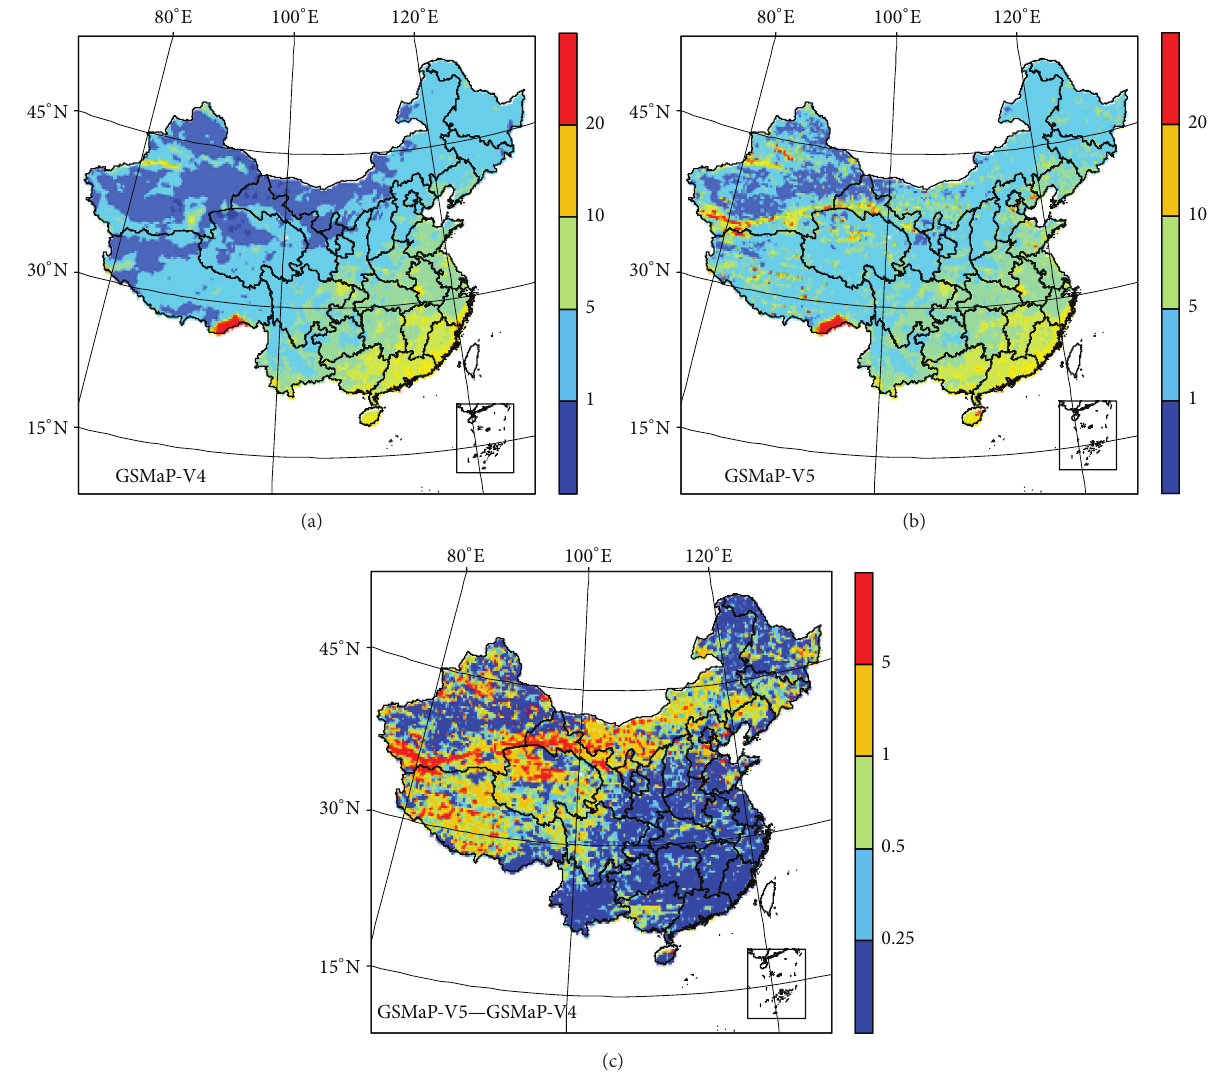
Figure 5: Distribution of root mean square errors for GSMaP products over the Chinese Mainland from 2003 to 2006. Units are mm/day. (a)